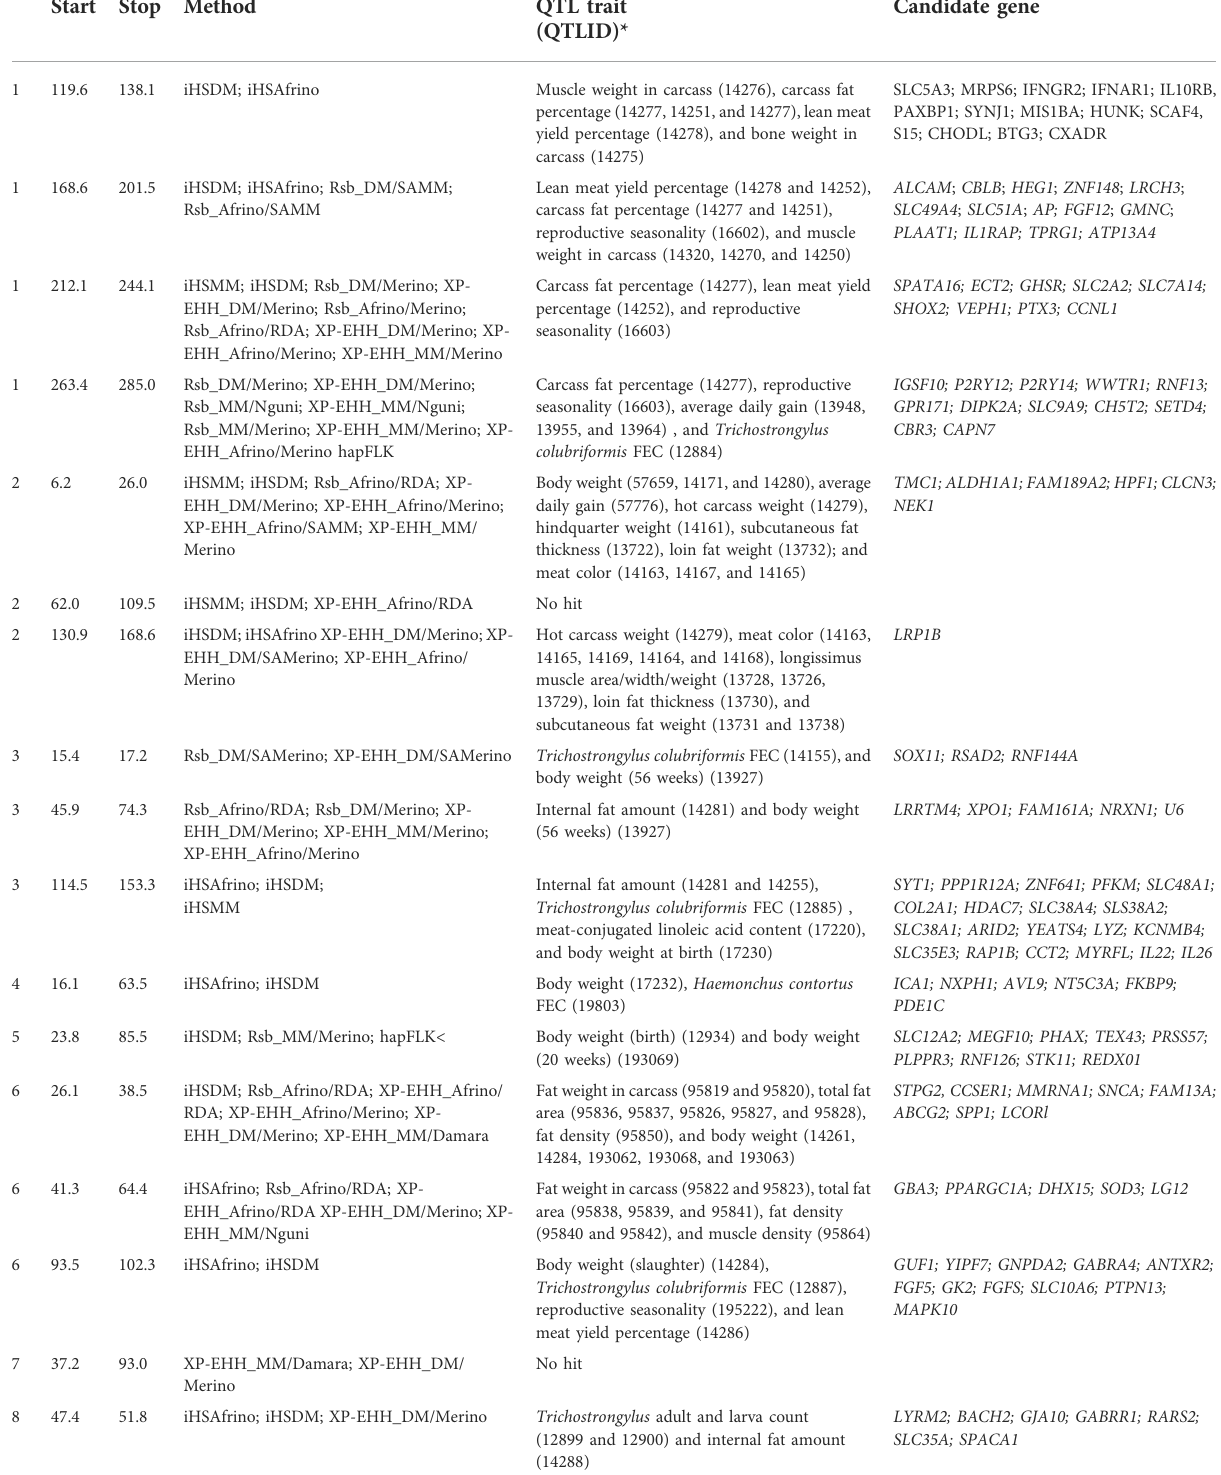
TABLE 4 iHS -based selection sweep regions and associated genes in Afrino, Dohne Merino, and Meatmaster sheep breeds and Rsb, XP-EHH and hapFLK-based selection sweep regions for Afrino, Dohne Merino, Meatmaster sheep breeds and their presumed ancestors. Start Stop